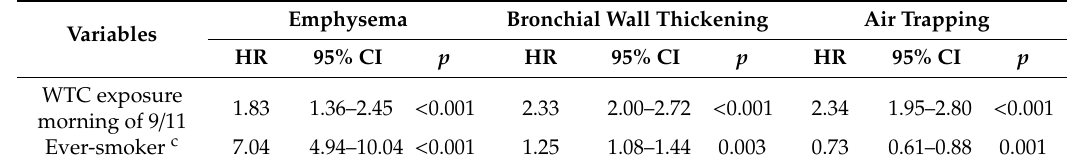
Table 3. Cox regression models predicting three Chest CT abnormalities a,b .